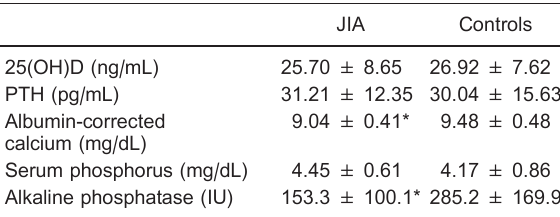
Table 2. Serum concentrations of 25(OH)D, PTH, calcium, phosphorus, and alkaline phosphatase of patients with juvenile idiopathic